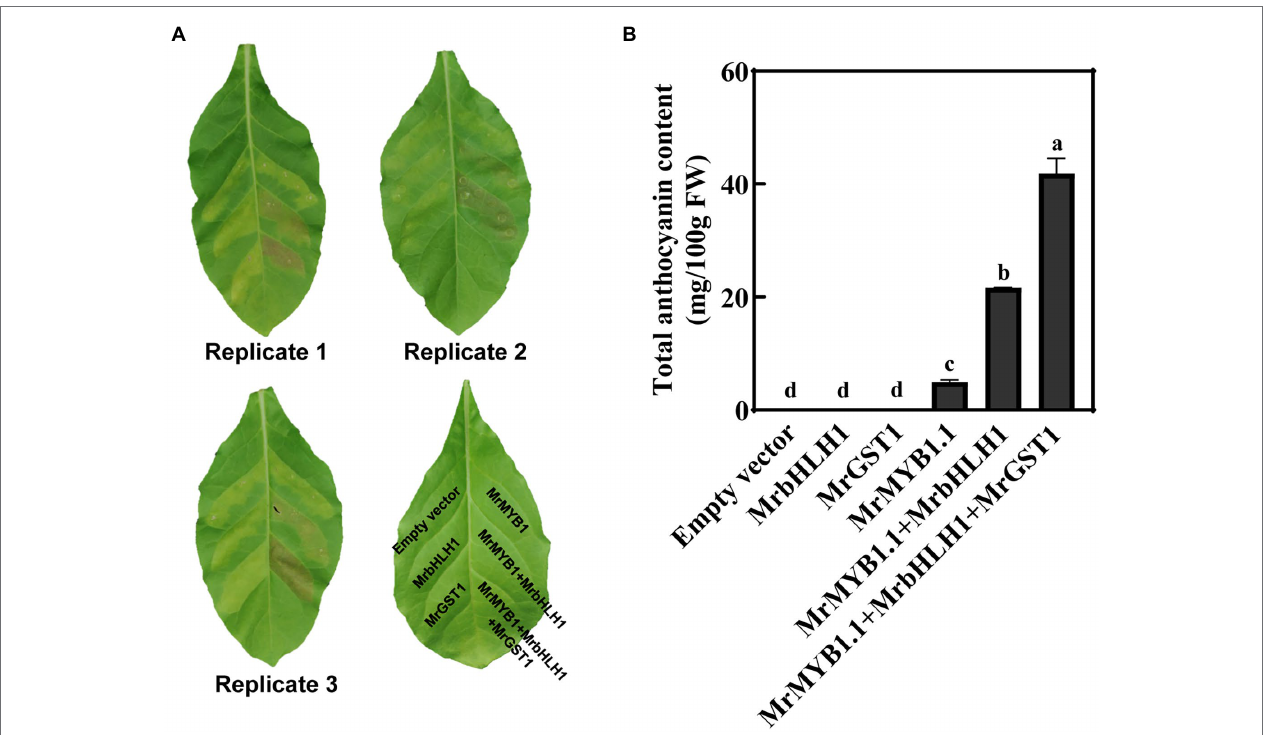
FIGURE 5 | Ectopic transient expression of MrGST1 in Nicotiana tabacum leaves. (A) Digital images of N. tabacum leaves were taken at 5 days after infiltration. (B) Total anthocyanin content of transformed leaves at infiltration sites. Anthocyanins were quantified as cyanidin-3- O -glucoside (C3G) equivalents. Data were means (±SE) from three independent biological replicates. Same letter indicates no significant difference ( p <